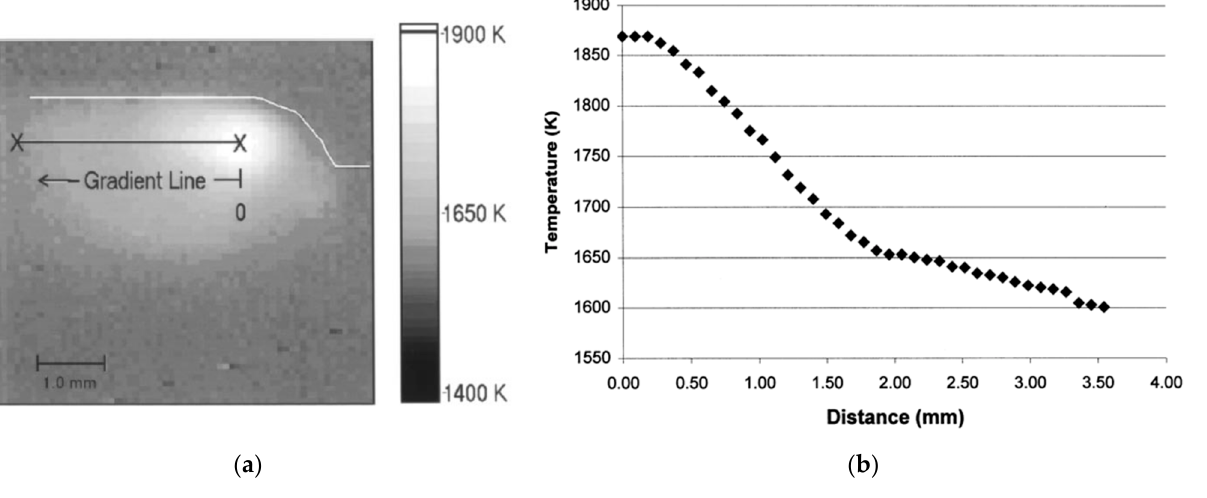
Figure 18. ( a ) Digital image of the working area during the deposition of 316L thin wall and ( b ) temperature distribution measured across the gradient line (reproduced with permission from [95]; Copyright © 1999 Elsevier).